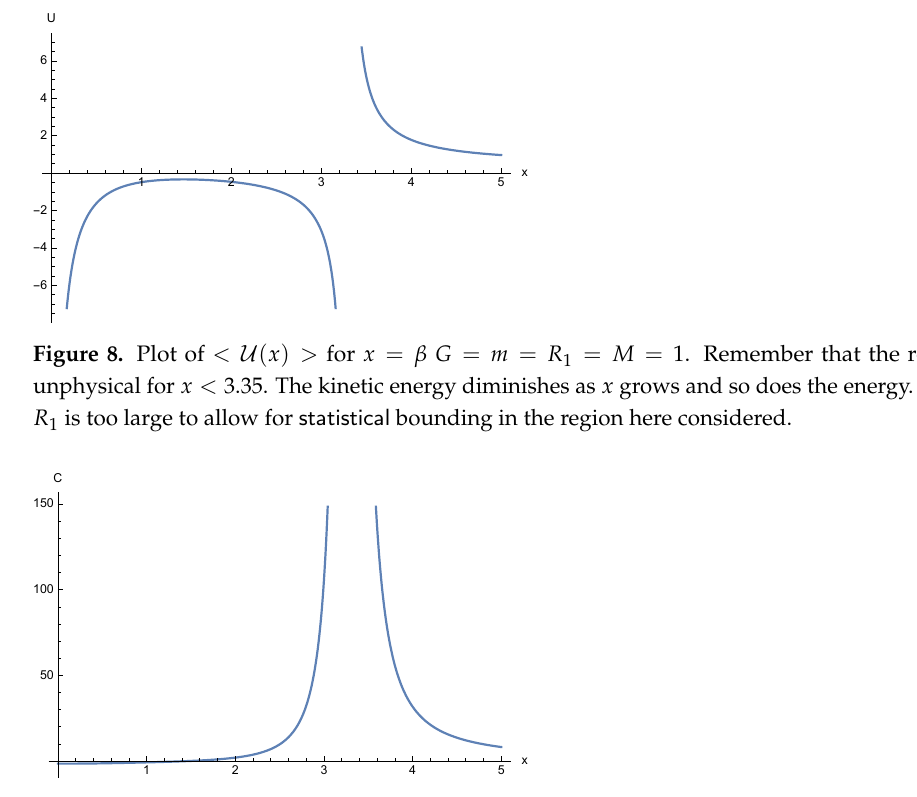
Figure 9. Plot of C ( x ) for x = β . One has G = m = R 1 = M = 1. Again, the results are unphysical for x < 3.35. The system tends to comply with the third law. It is unbound, since C >